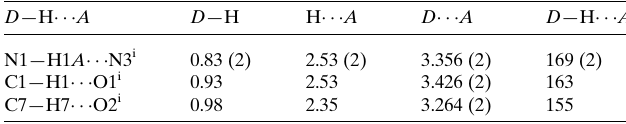
Table 2 Hydrogen-bond geometry (A˚ , (cid:3) ) for (II).